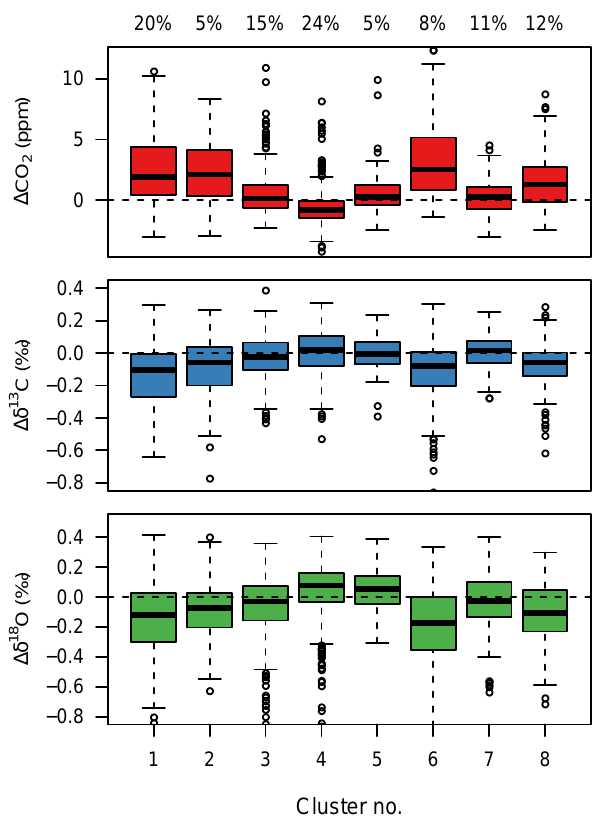
Fig. 10. Boxplots of CO 2 , δ 13 C and δ 18 O deviations from the back- ground concentrations ( 1 ) for the winter months (December to February) classified by the different footprint clusters. The boxes show the interquartile range and the whiskers extend to the most extreme data point, which is no more than 1.5 times the interquar- tile range away from the box. The percentages at the top indicate the cluster frequencies.